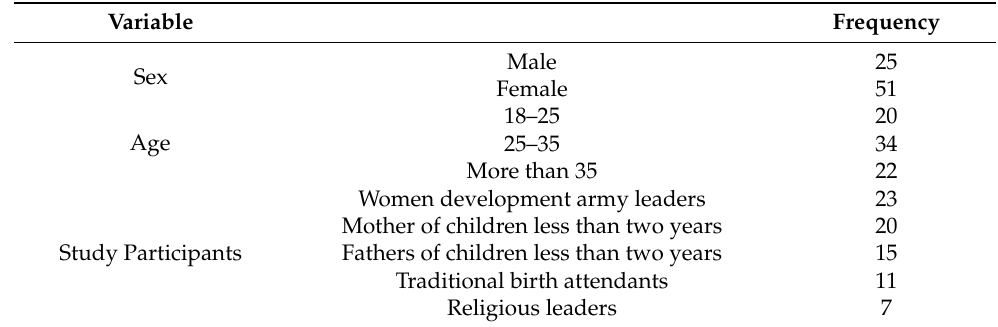
Table 1. Background information of research participants.